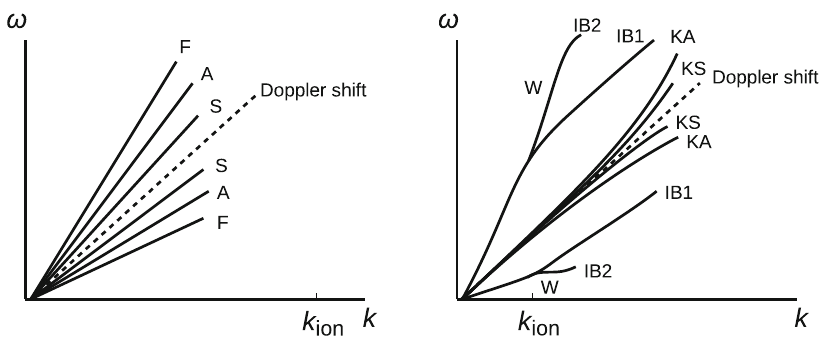
Fig. 6 Sketches of dispersion relations in the Eulerian frame for magnetohydrodynamic waves (“F” for the fast mode, “A” for the Alfvén mode, and “S” for the slow mode) on the left panel and ion-kinetic waves obtained from the linear Vlasov theory for a quasi-perpendicular propagation to the mean magnetic field (“KS” for the kinetic slow mode, “KA” for the kinetic Alfvén mode, “W” for the whistler mode, “IB1” for the fundamental ion Bernstein mode, and “IB2” for the second harmonic of the ion Bernstein